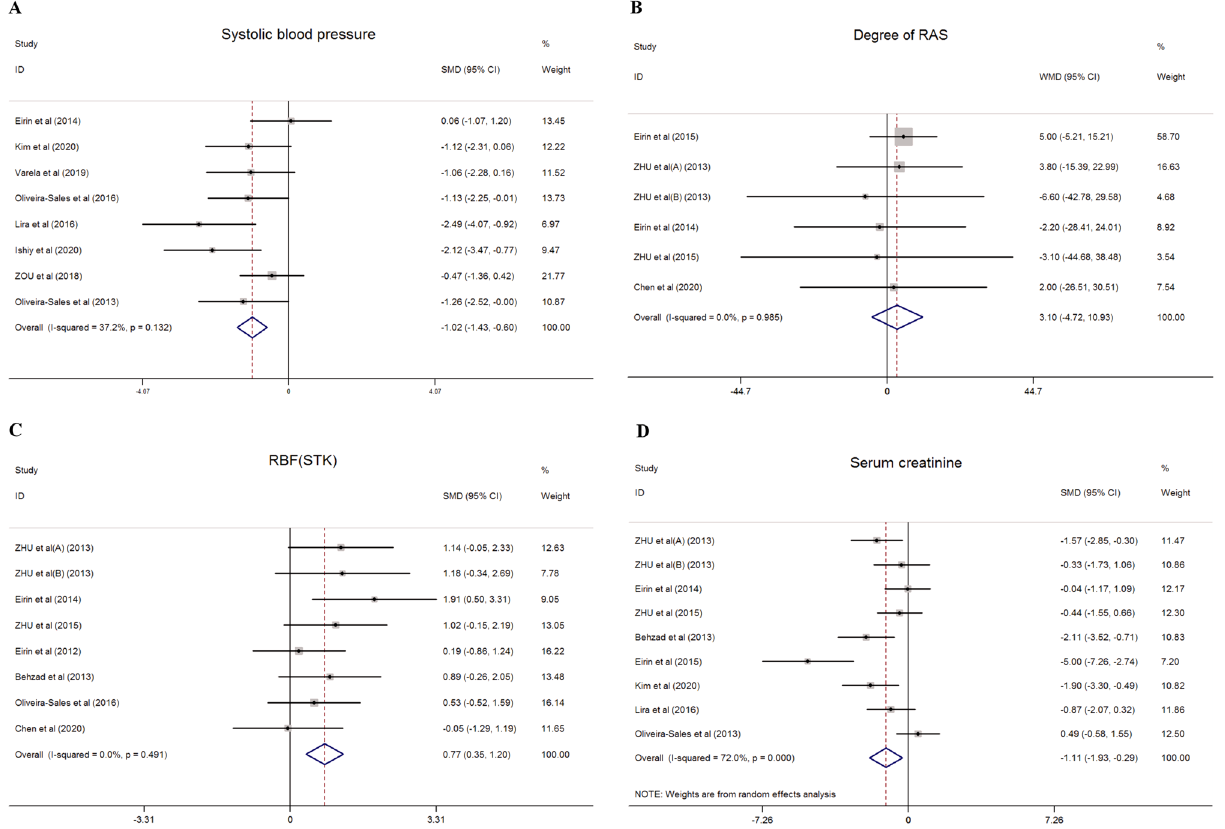
Figure 2. The effect of MSC therapy on systolic blood pressure ( A ), the degree of renal artery stenosis ( B ), renal blood flow of stenotic kidney ( C ) and serum creatinine ( D ) in preclinical